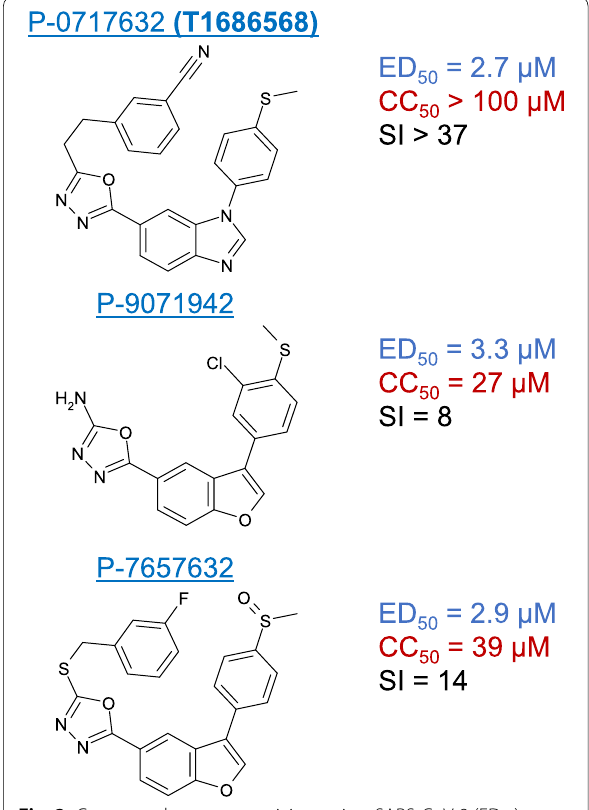
Fig. 2 Compound structure, activity against SARS‑CoV‑2 (ED 50 ) and toxicity to Huh‑7.5.1 cells (CC 50 ). Data is derived from four independent